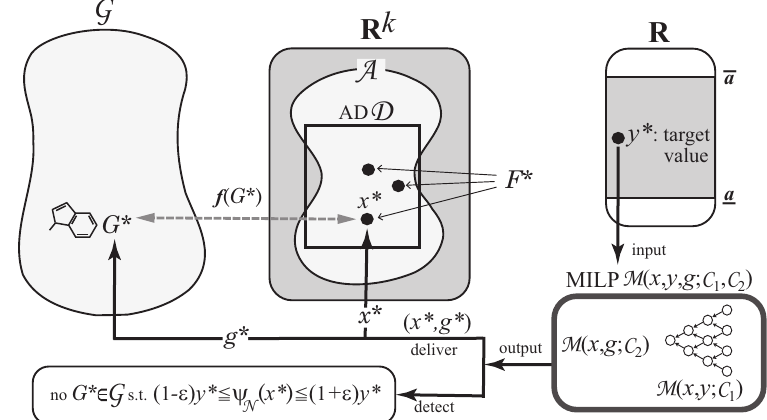
Figure 6. An illustration of Step 4: Given a target value y ∗ ∈ [ a , a ] , solving MILP M ( x , y , g ; C 1 , C 2